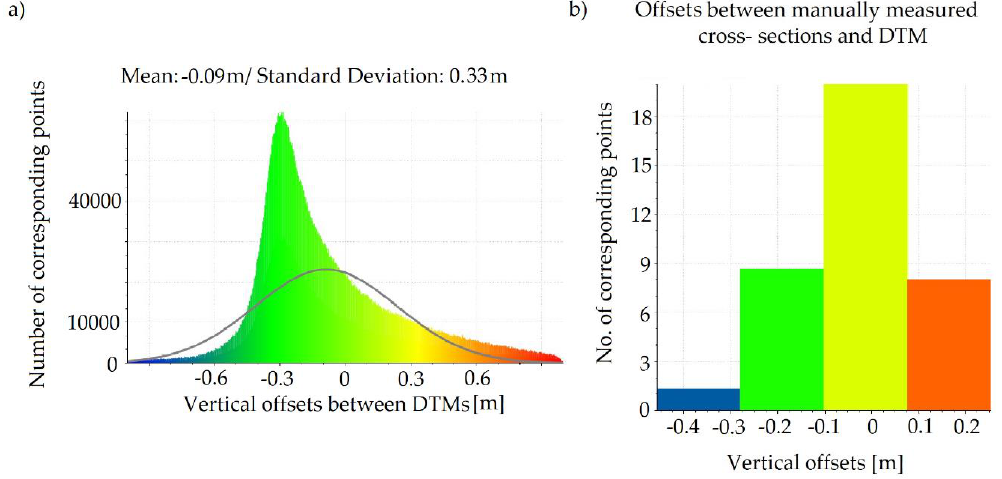
Figure 6. Analysis of the obtained bottom extraction material from photos comparing the distance between ( a ) the measured digital terrain model (DTM) and the DTM from the Central Geodetic Centre in Poland; and ( b ) a comparison of the results of depth measurements to those made manually. The colour palette indicates values from the lowest (marked in blue) to the highest (marked in red).